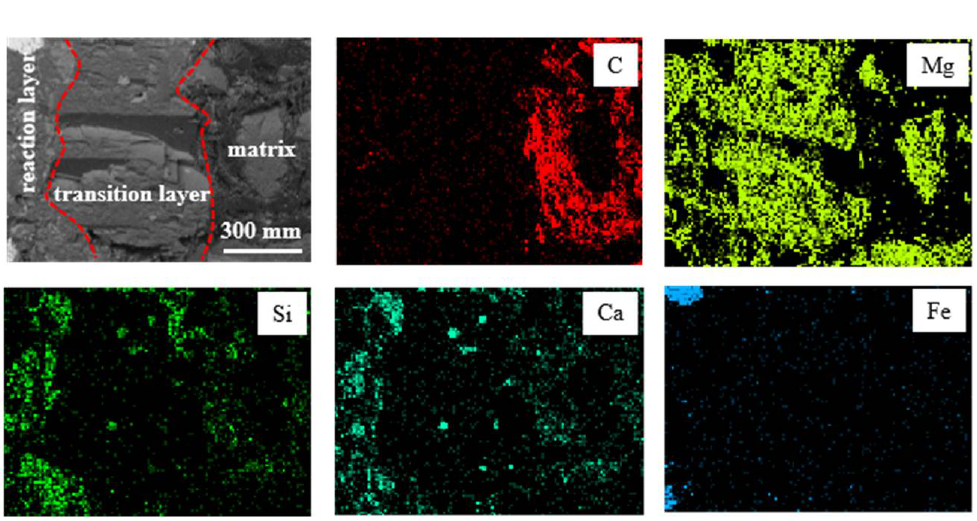
Figure 3. Average mass fraction of Al 2 O 3 and MgO in CaO-Al 2 O 3 -MgO-SiO 2 inclusions.